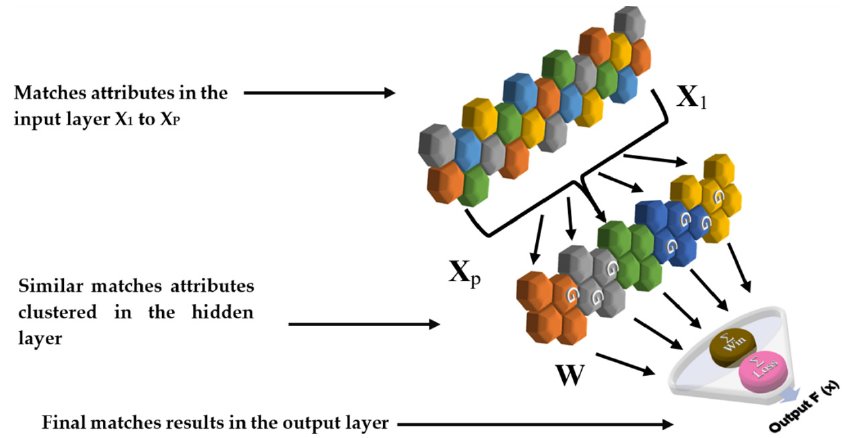
Figure 1. Radial Basis Function (RBF) network. G is Gaussian function, W is weights .